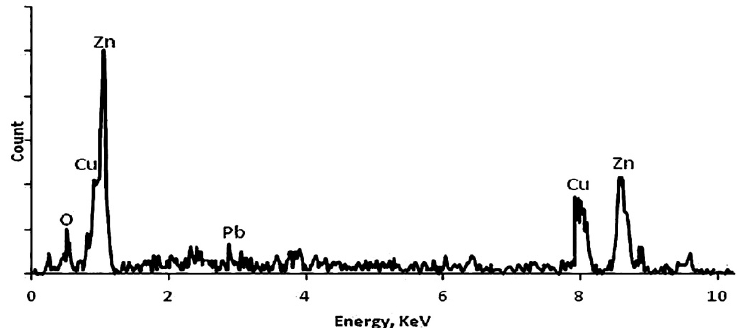
Figure 3. Energy dispersive X-ray analysis of the flowery oxides formed on the thermal